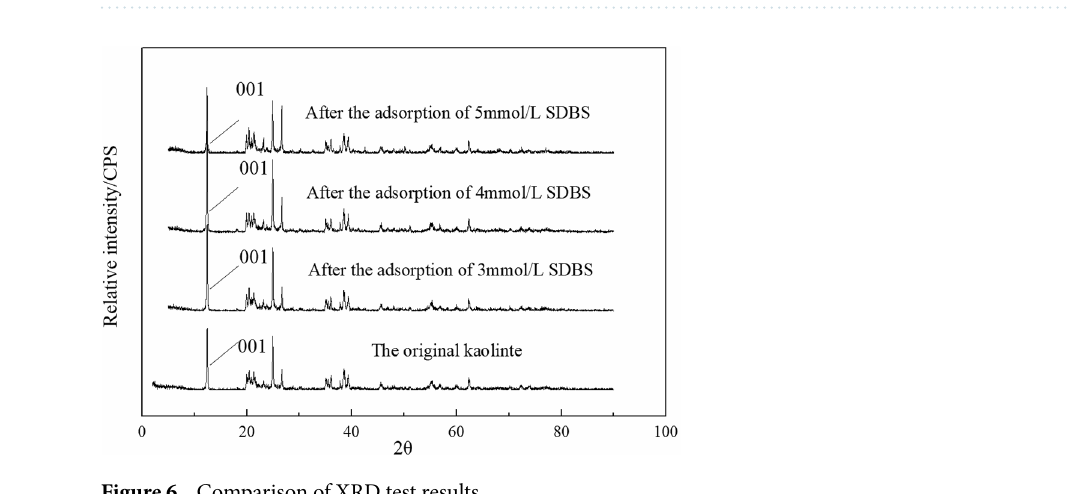
Figure 6. Comparison of XRD test